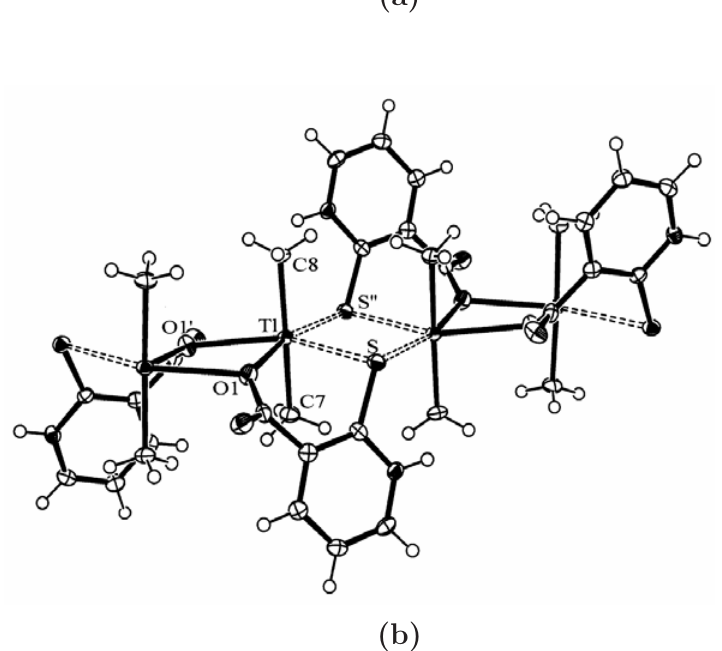
Fig. 1 ORTEP plots of 1 showing (a) the numbering scheme in the asymmetric unit and the dimmer association and (b) fragment of the polymeric